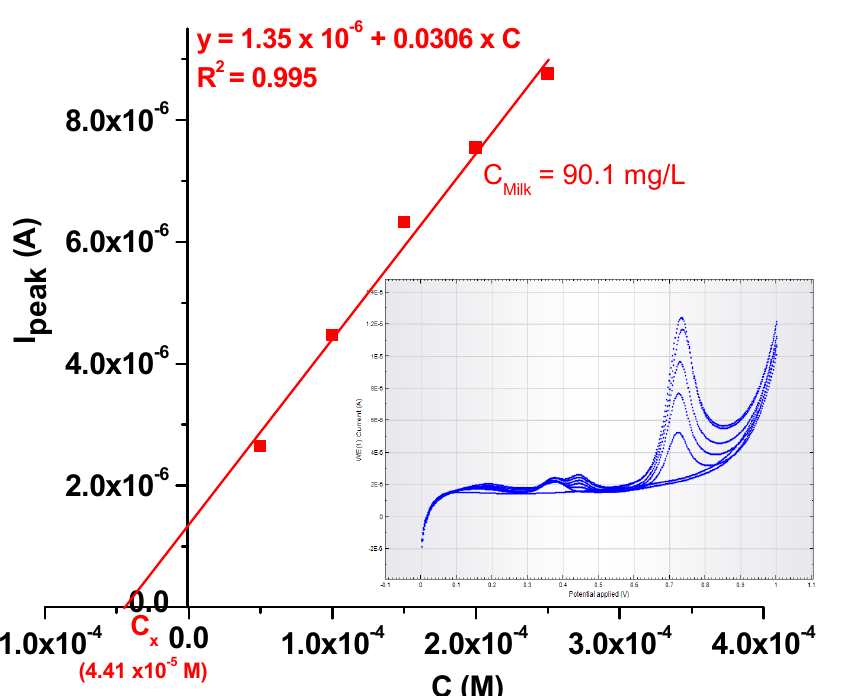
Figure 12. Calibration plot obtained with the EGr/GC electrode after standard addition of TRP in a milk sample. Inset: the LSVs recorded at various L ‐ tryptophan concentrations (from 5 × 10 − 5 to 2.5 × 10 − 4 M) in milk. Table 3. Comparison of the analytical performance of various electrodes modified with graphene-based materials. Electrode/Sensing